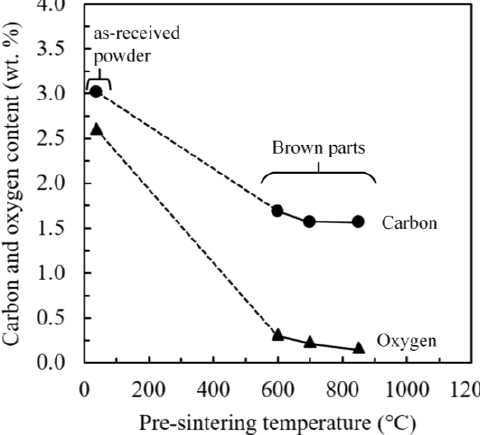
Figure 6. Evolution of the carbon and oxygen contents as functions of the pre-sintering tempera- ture.